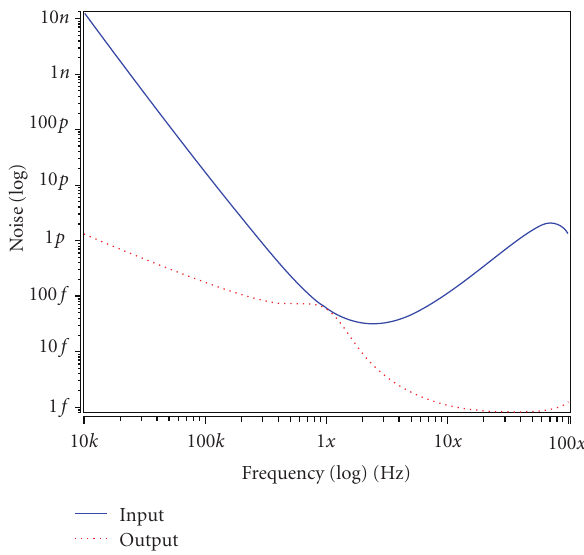
Figure 4: Equivalent output and input noise of the bandpass filter versus frequency.